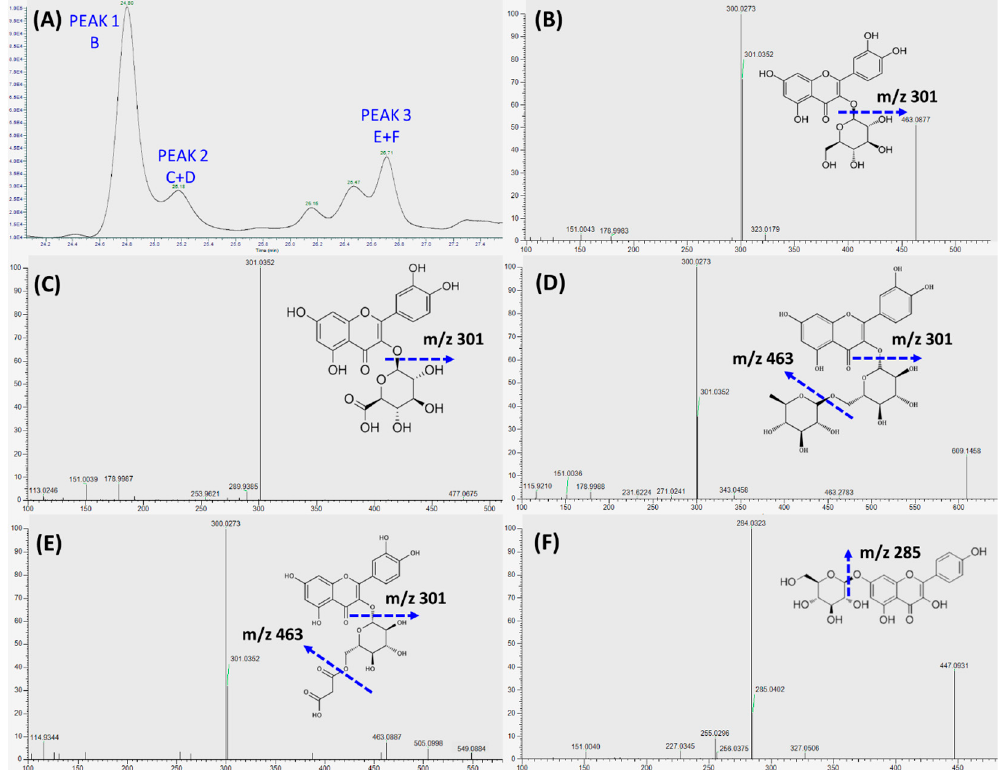
Figure 5. Identification of transepithelial phenolic compounds within 24 h RDE incubation. RDE (100 μ g/mL) was supplemented to the apical compartment (Caco-2 BBe1 cell monolayer located) of Transwell® plate. ( A ) Chromatographic profiles (280 nm) of the absorbed and transported phenolic compounds in the medium collected from the basolateral compartment. The fragmentation pattern of the major identified polyphenols from three peaks were characterized by LC-MS/MS, the identified flavonoid for peak 1 are shown in ( B ), the identified polyphenols for peak 2 are shown in ( C ) and ( D ), and the identified polyphenols for peak 3 are shown in ( E ) and ( F ).